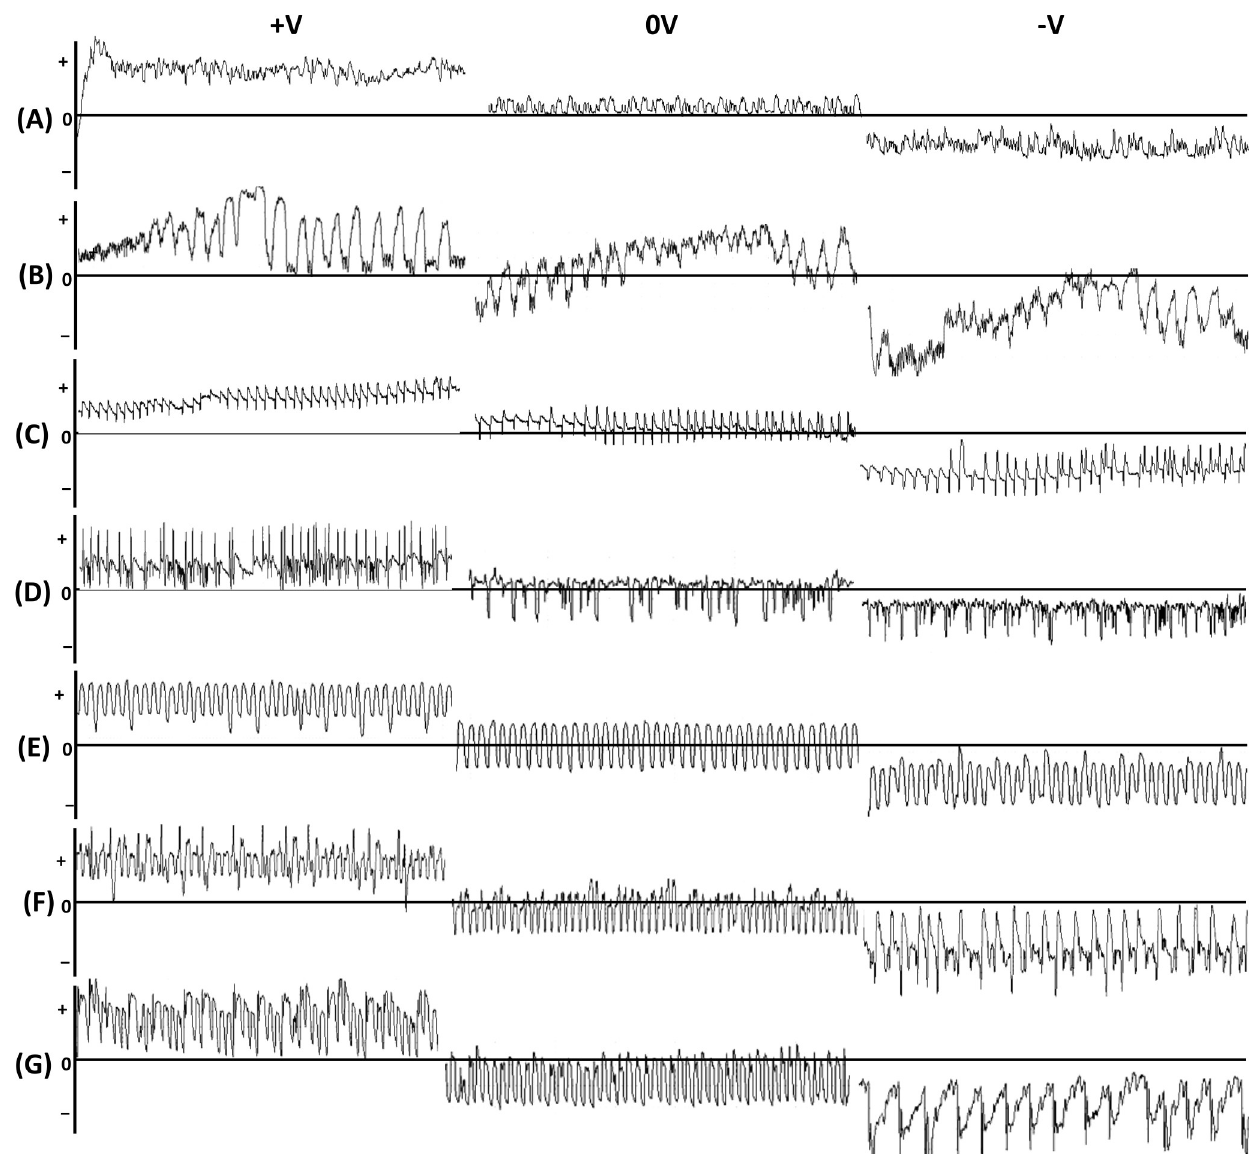
Fig 3. Assessment of the R and emf components contribution to each waveform by plant voltage adjustments, positive (+), zero (0) and negative ( − ). Adjustments of the plant voltage during recording. (A) Waveform AC1; 30 s traces, resolution 2.5V. (B) Waveform AC2; 60 s traces, resolution 2.5V. (C) Waveform AE1; 60 s traces, resolution 1V. (D) Waveform AE2; 60 s traces, resolution 1V. (E) Waveform AE3; 10 s traces, resolution 1V. (F) Waveform AE3; 30 s traces, resolution 1V. (G) Waveform AG; 30 s traces, resolution 1V.